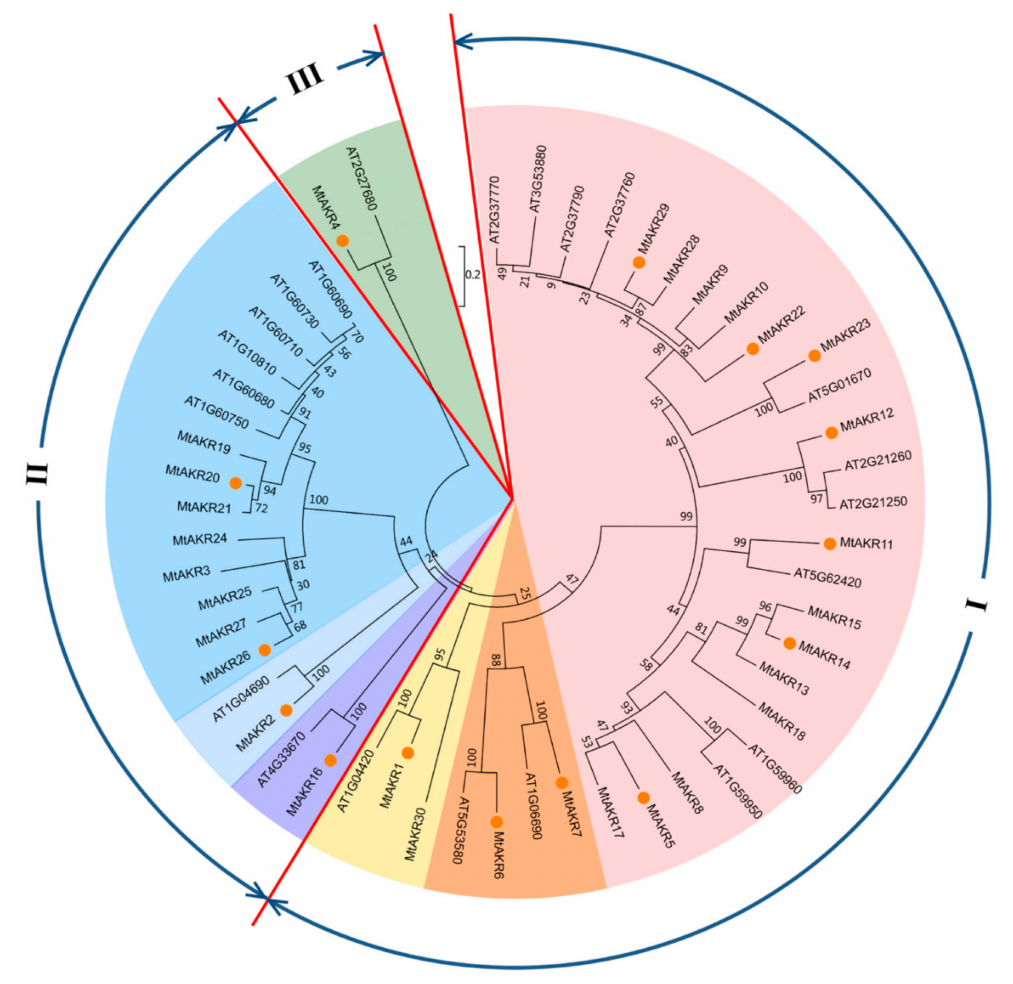
Figure 5. Phylogenetic tree of AKRs from M. truncatula and A. thaliana . The deduced full-length amino acid sequences were aligned by using ClustalW, and the phylogenetic tree was constructed by using the neighbor-joining (NJ) method in MEGA 7.0, with 2000 bootstrap replicates. Three groups and six subgroups are indicated. The genes marked with orange dots were subjected to expression